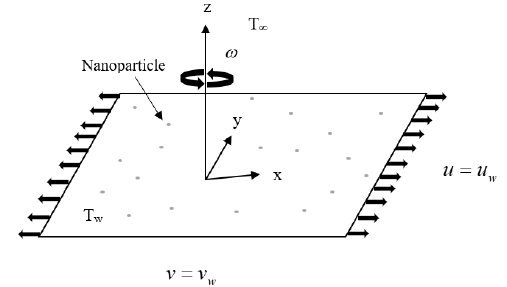
Figure 1. Physical